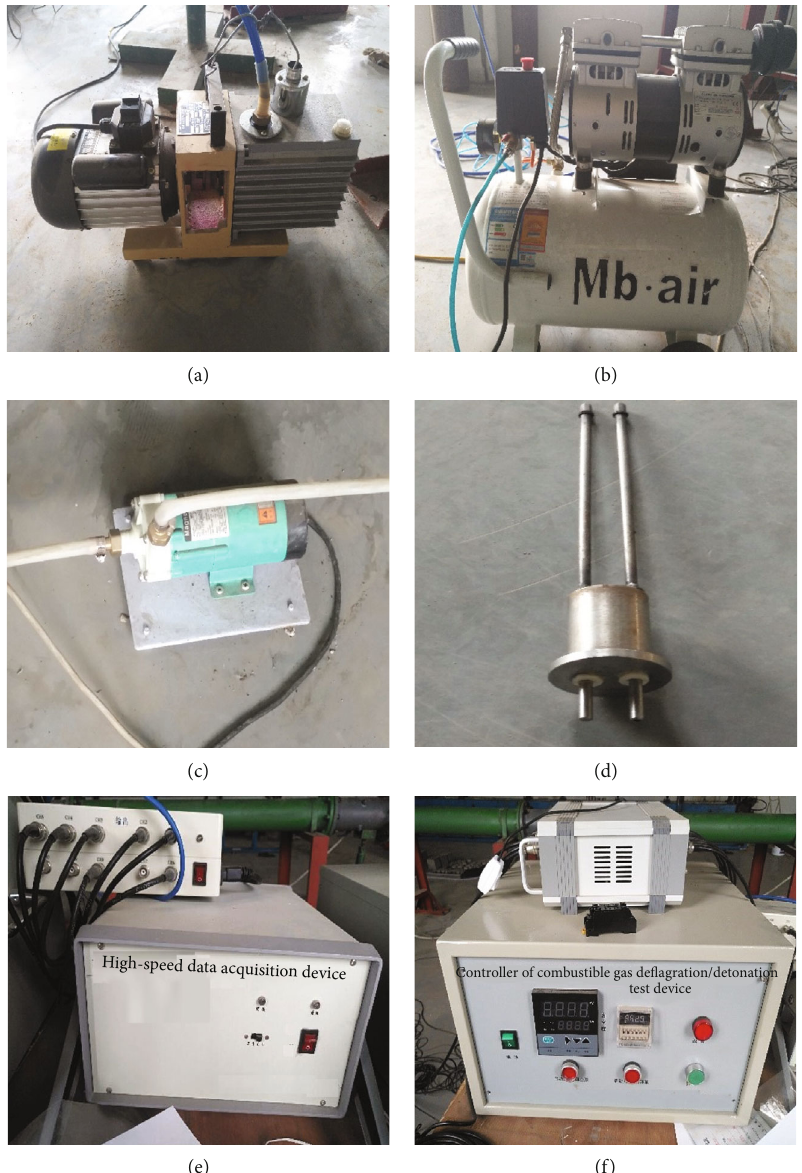
Figure 2: Main equipment of gas explosion experiment system: (a) vacuum pump, (b) air compressor, (c) circulating pump, (d) ignition electrode, (e) high-speed data acquisition device, and (f) gas explosion device